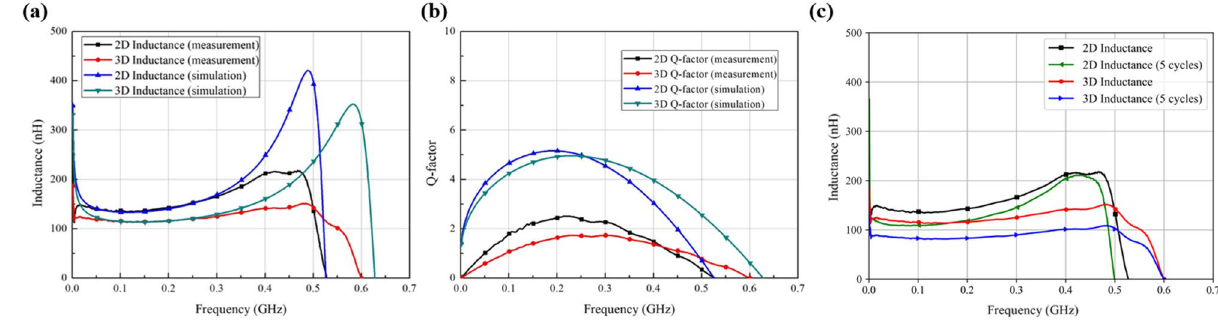
Figure 4. Measurements of the characteristics of the fabricated inductor: ( a ) inductance, ( b ) Q-factor, ( c ) after 5 times repeating